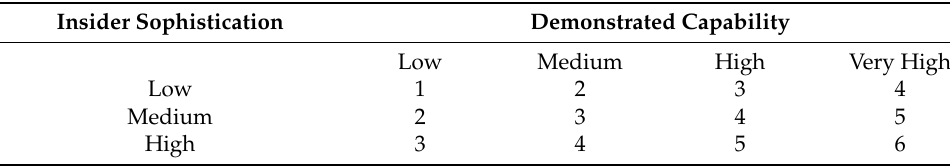
Table 4. Capability Score.